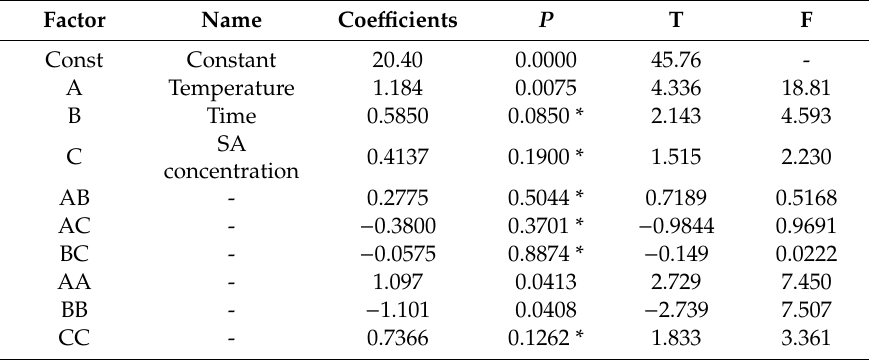
Table 4. RSM coe ffi cients and P, T and F-values for the polynomial